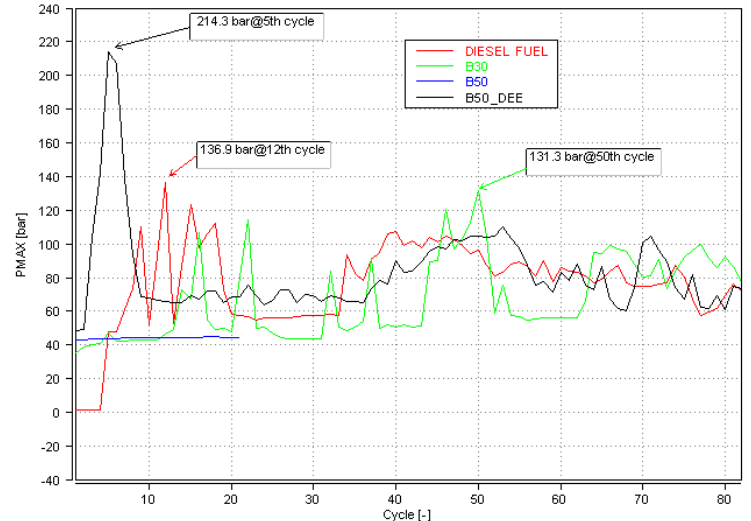
Figure 8. Pressure peaks’ cyclic evolution.